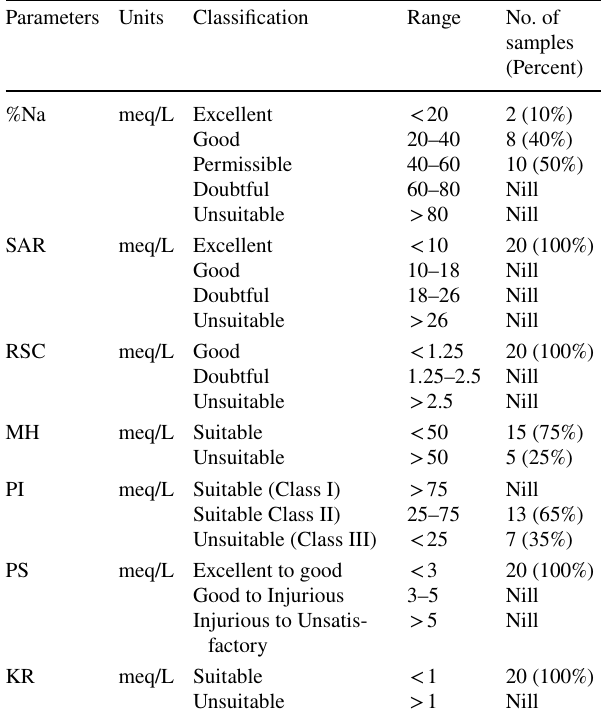
Table 4 Summary of the classification of groundwater for irrigation based on different parameters